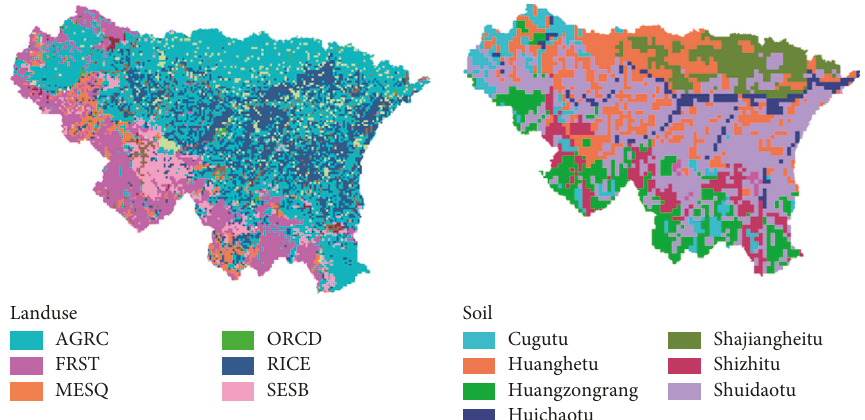
Figure 2: Land use/land cover (LU/LC) classes and soil distribution for the upper Huai River